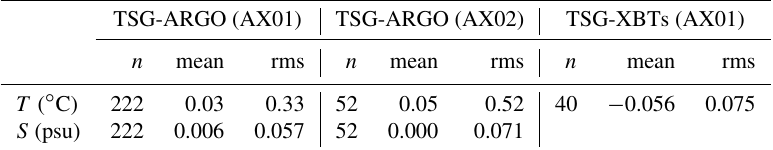
Table A1. Statistical summary of the comparisons of collocated Argo data (at 3–9m) with TSG data along AX01 and AX02 (within 58– 61 ◦ N) (with temperature and salinity differences less than 1 ◦ C and 0.2psu, respectively) and summary of comparison of simultaneous XBT (at 7m) and TSG temperature transects along AX01 (for each transect, the average difference is estimated, and retained if the standard deviation of the differences in individual matches is less than 0.2 ◦ C). In each case, average and rms standard deviations are